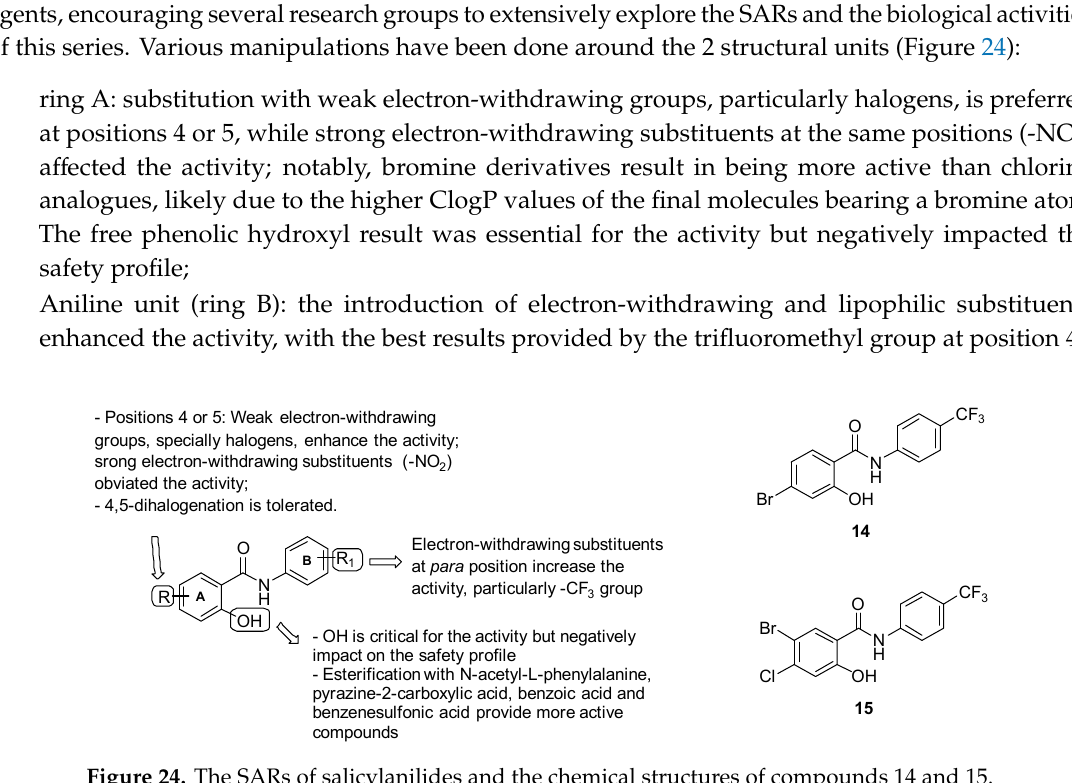
Figure 24. The SARs of salicylanilides and the chemical structures of compounds 14 and 15.